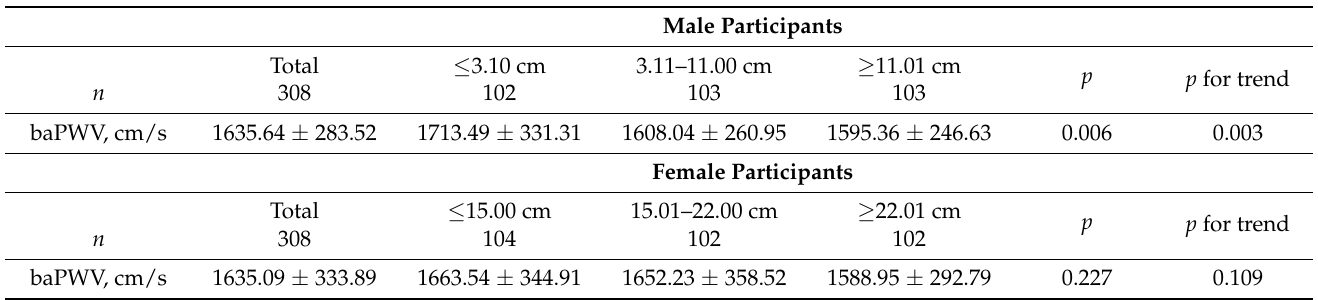
Table 2. The trend of the baPWV according to the sit-and-reach test result tertiles. Male Participants